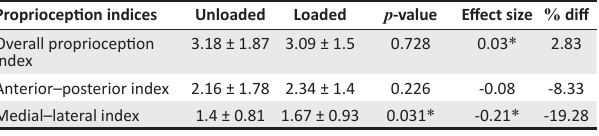
TABLE 2: Comparative review of participants’ proprioception when unloaded and head-loaded ( n =